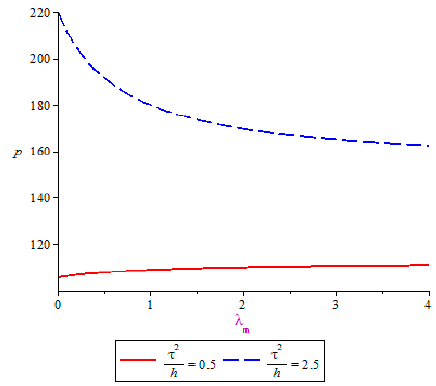
Figure 5. The impact of loss-aversion coefficient on retail price.